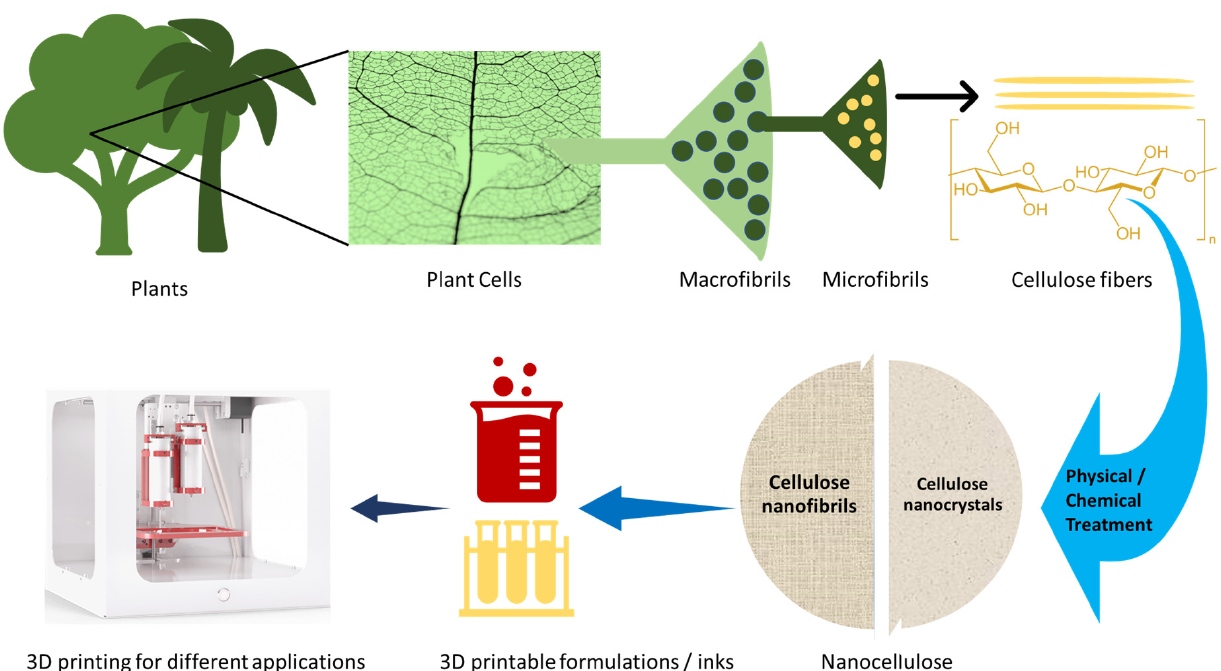
Figure 1. Schematic diagram of nanocellulose: source, processing, and 3D printability. Cellulose, poly(1,4- D -glucose), is one of the most widespread natural renewable resources on Earth and represents a potential source of high-value products. Cellulose is abundant, can be produced inexpensively on a large scale from sustainable sources, is